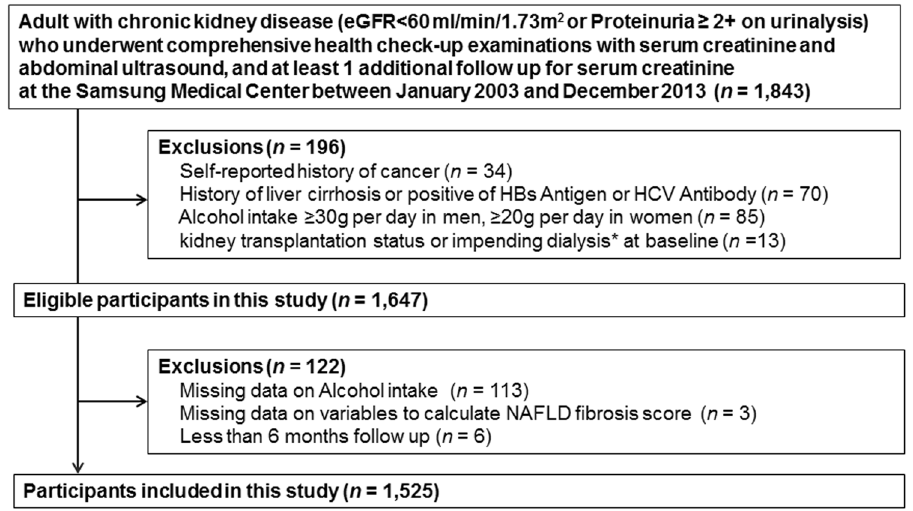
Figure 2. Flow chart of study patients (n = 1,326). * Impending dialysis represents patients who started dialysis within 1 year after the baseline health check-up